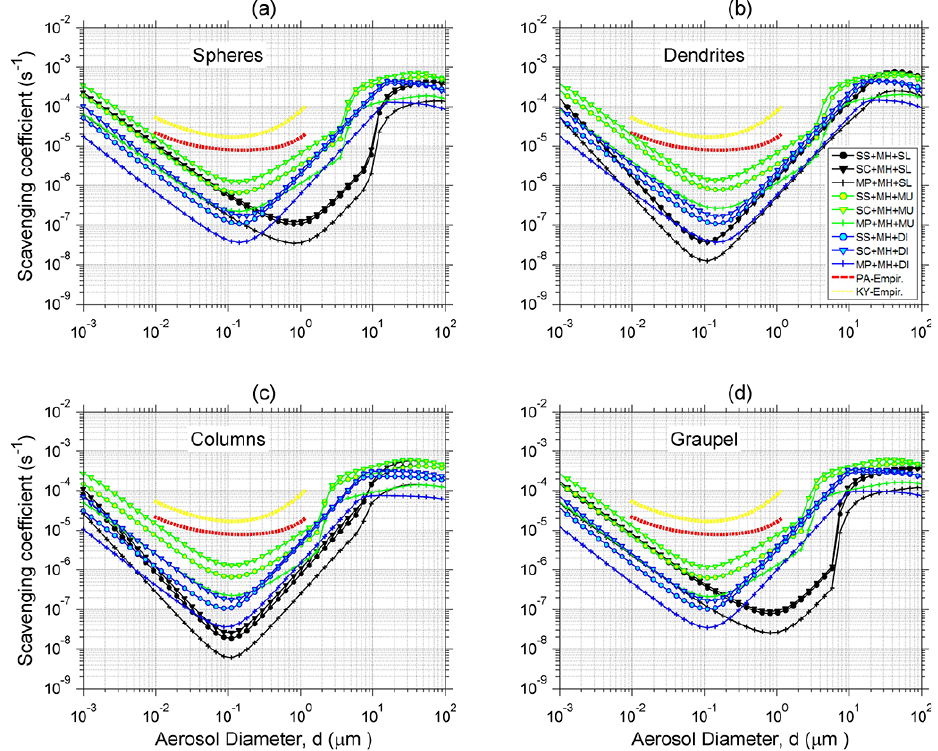
Fig. 7. Size-resolved 3 snow profiles derived from nine theoretical parameterizations generated by a combination of three different E(d p ,D p ) and three different N(D p ) formulas for a snowfall intensity (as liquid water equivalent) of 0.1mmh − 1 for four different snow-particle